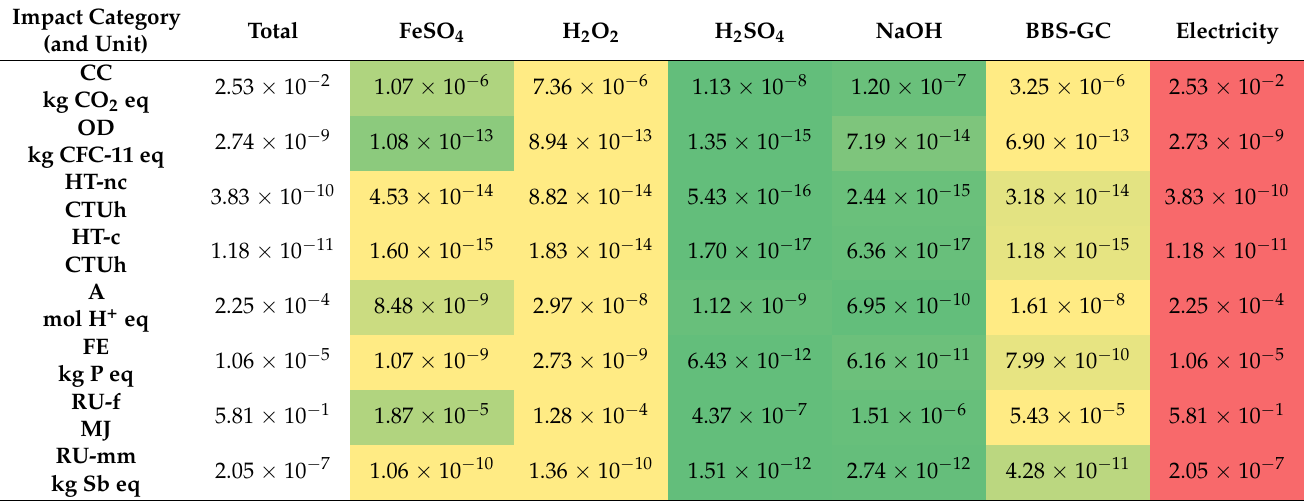
Table 9. LCIA results for the photo Fenton process, at laboratory level: treatment of 250 mL of water contaminated with 5 mg/L of caffeine, at pH 5.0, using BBS-GC as complexing